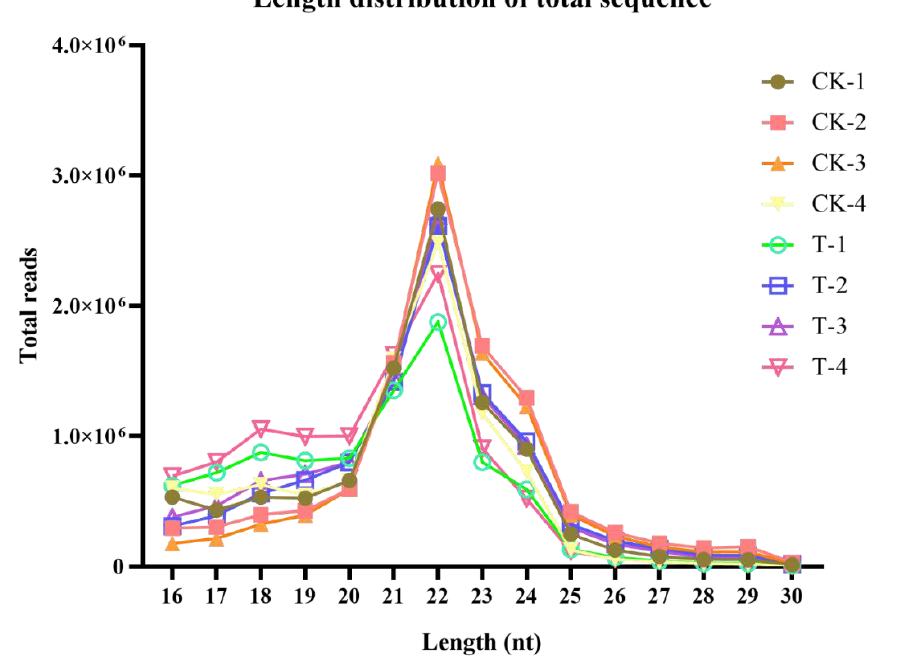
Figure 4. The length distribution of the small RNA sequence. CK-1, CK-2, CK-3, and CK-4, the control group; T-1, T-2, T- 3, and T-4, the naringenin group.